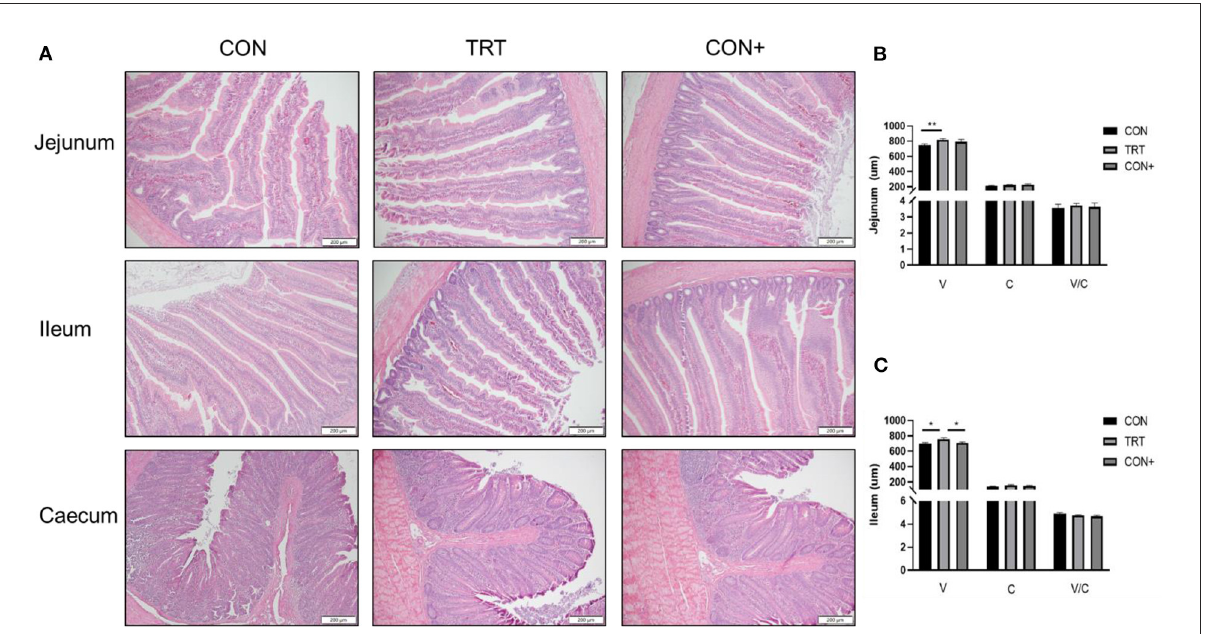
FIGURE3 Effect of different treatments on intestinal morphology. (A) Intestinal morphology of the jejunum, ileum and caecum in AA broilers. Representative pictures of different intestinal segments were shown, bar = 200 µ m. (B) Height of jejunum villi in different treatment groups. (C) Height of ileum villi in different treatment groups. n = 6. * P < 0.05; ** P <